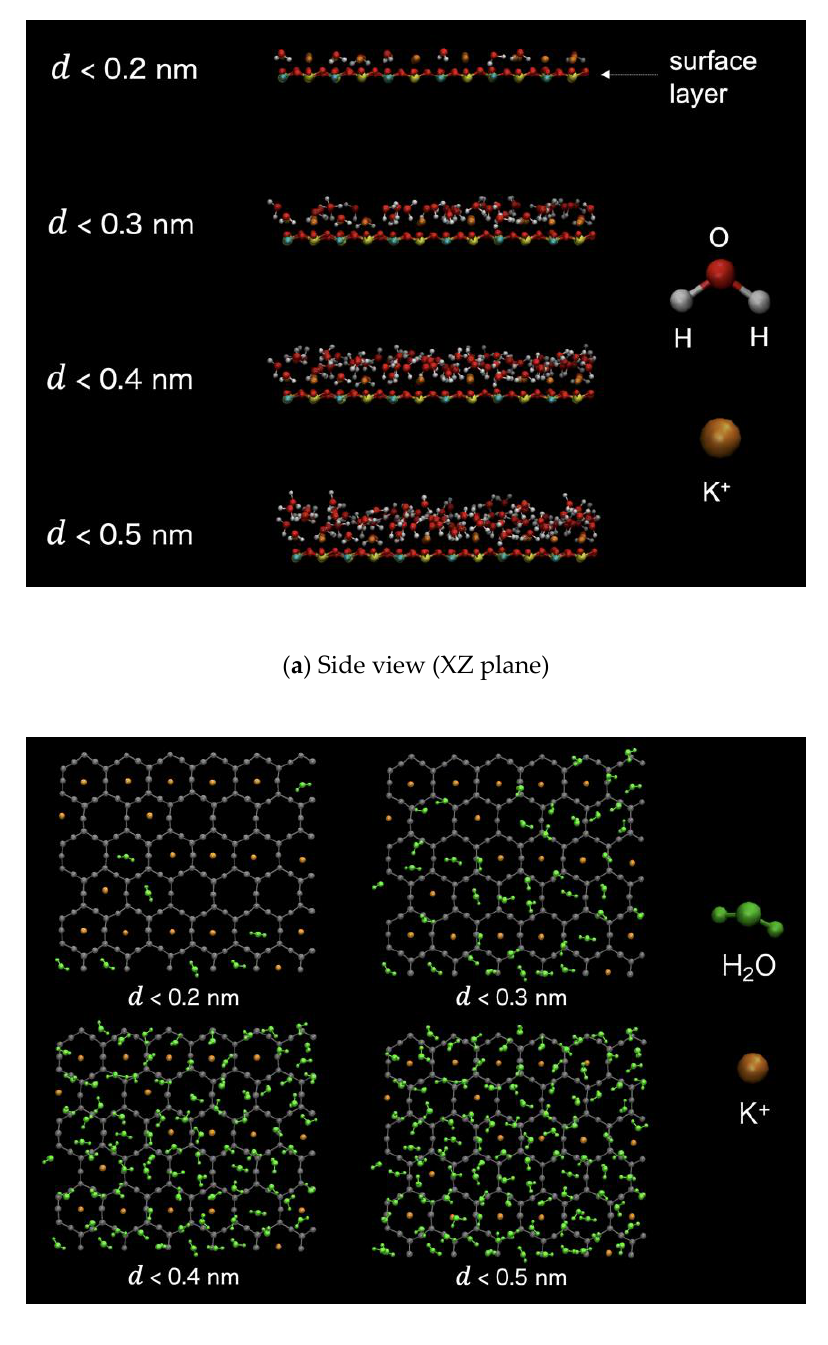
Figure 5. Snapshots of the muscovite surface, K + , and H 2 O molecules.